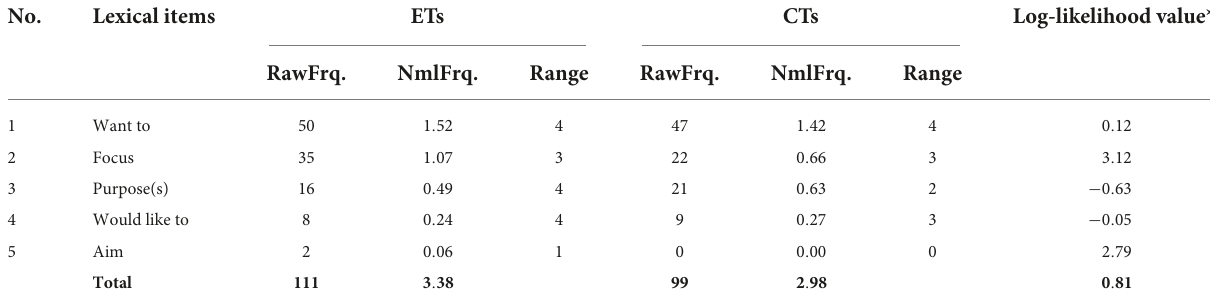
TABLE 8 Summary of announcing goals in both